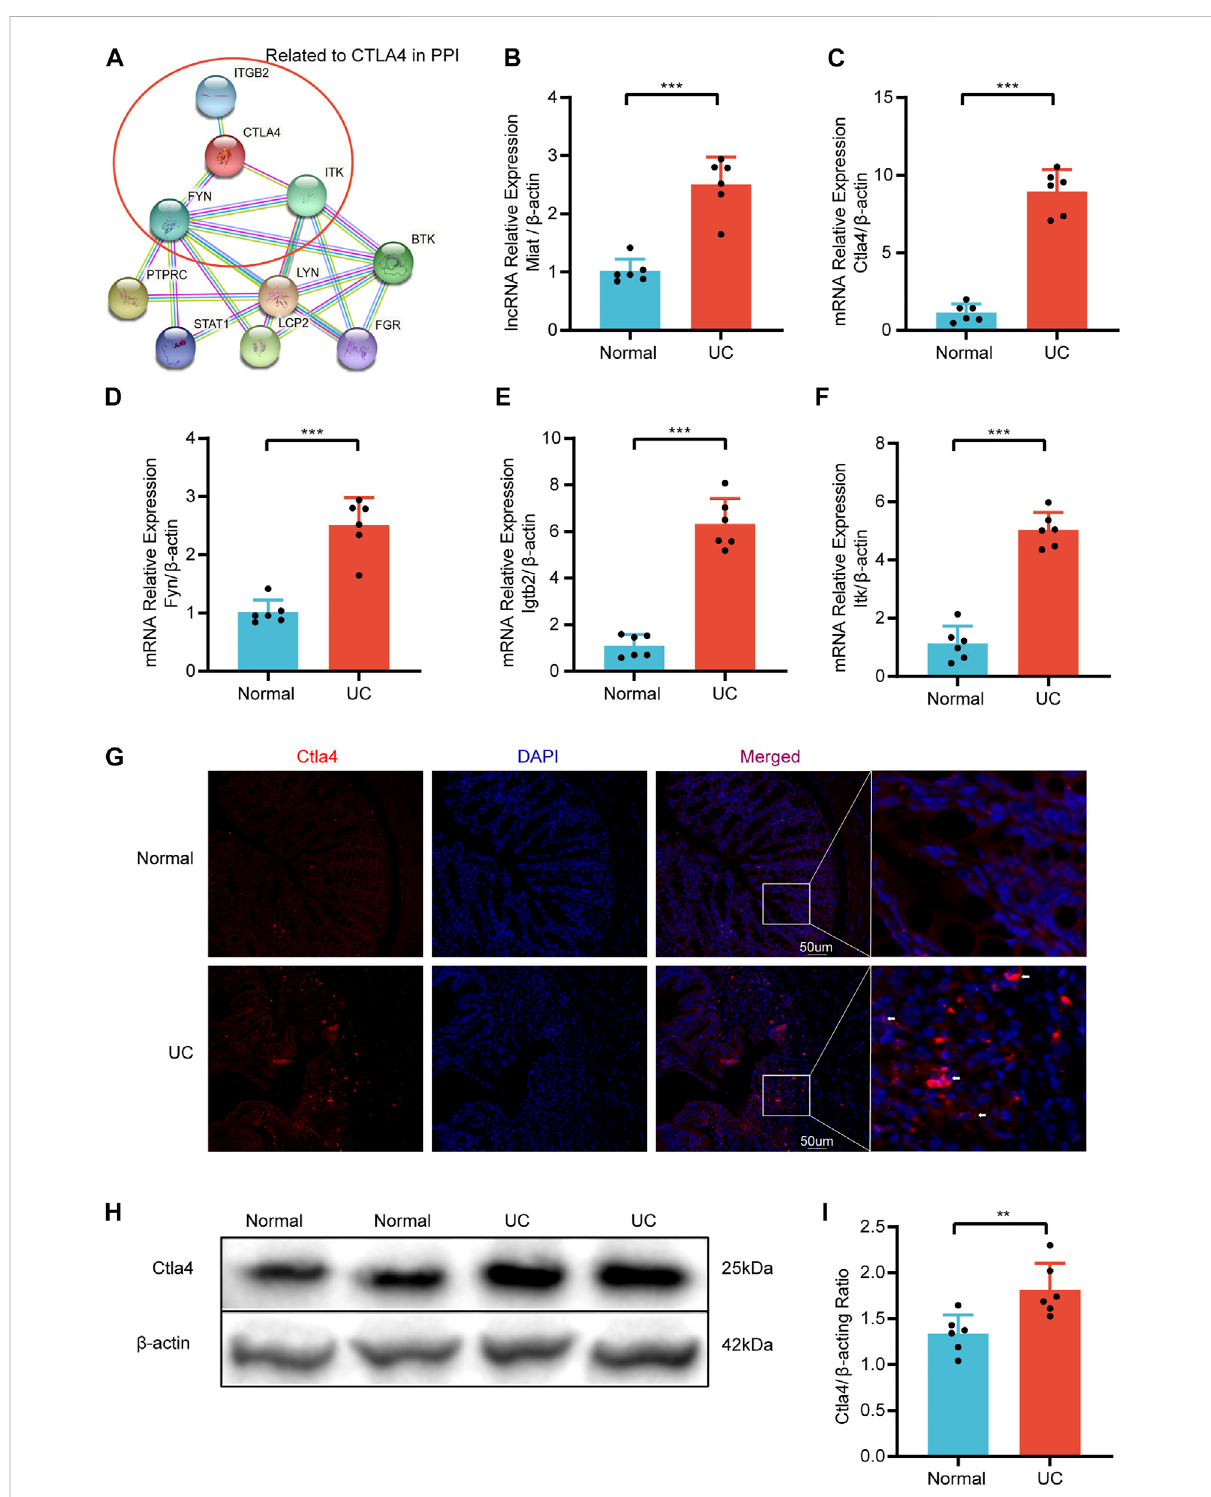
FIGURE 9 TherelativeexpressionwasvalidatedviaqRT-PCR. (A) HubmRNAsRelatedto CTLA4 inPPI.Therelativeexpressionof Miat (B) , Clta4 (C) , Fyn (D) , Igtb2 (E) , and Itk (F) in DSS-induced mice and Normal mice. (G) Representative immuno fl uorescence image of CTLA4 between DSS-induced mice and Normal mice. Red, Ctla4 ; blue, DAPI nuclear staining (n = 6/group). (H) Representative western blot image of Ctla4 between DSS-induced mice and Normal mice. (I) Quanti fi cation of western blot analysis. Dates are shown as mean ± SD. ** p < 0.01, *** p <